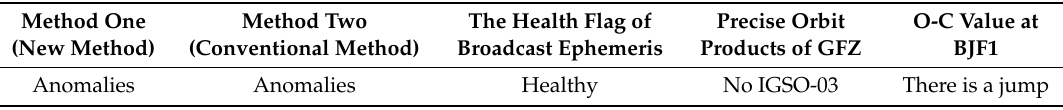
Table 2. Results of IGSO-03 maneuvering detection at 10:00–11:00.